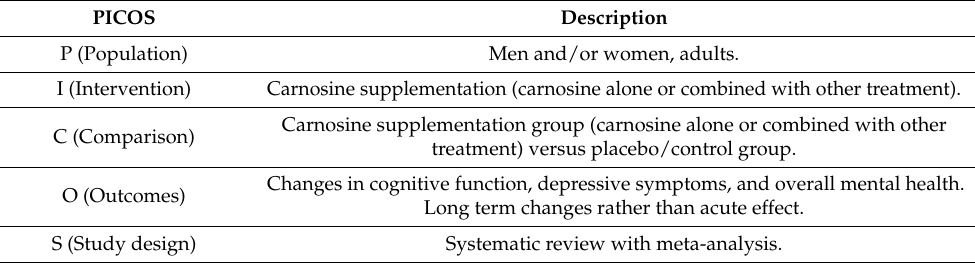
Table 1. PICOS criteria.